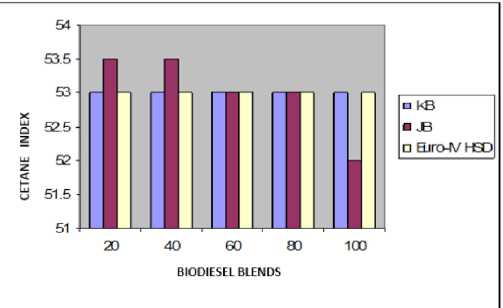
Figure 7. Variation of cetane index of Jatropha curcus and Pongamia pinnata methyl esters blends with EURO-IV